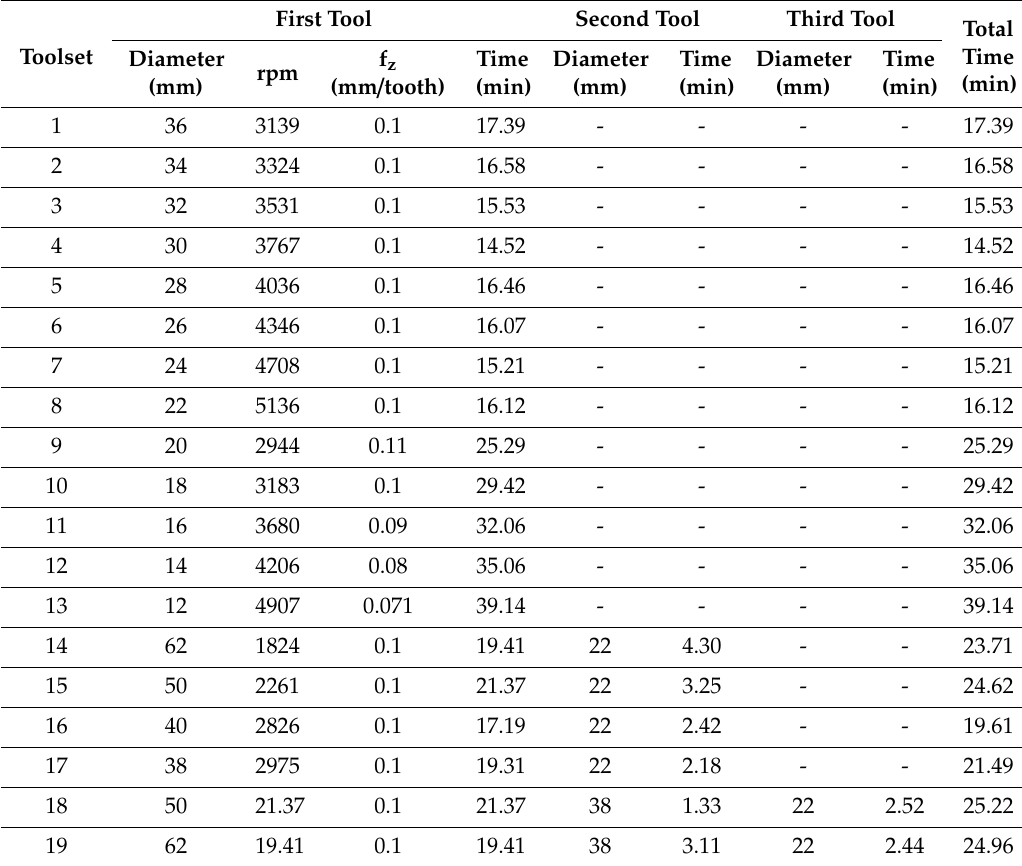
Table 7. Relevant toolsets for rough contour